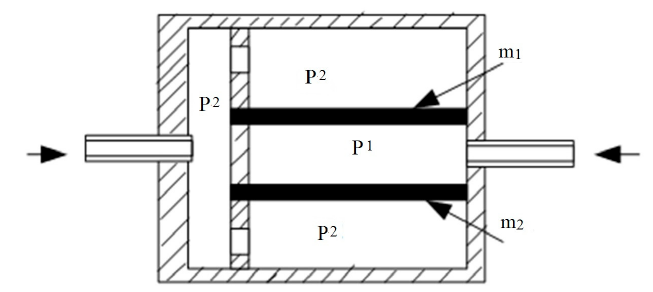
Figure 11. Acceleration-free transducer geometry [4].